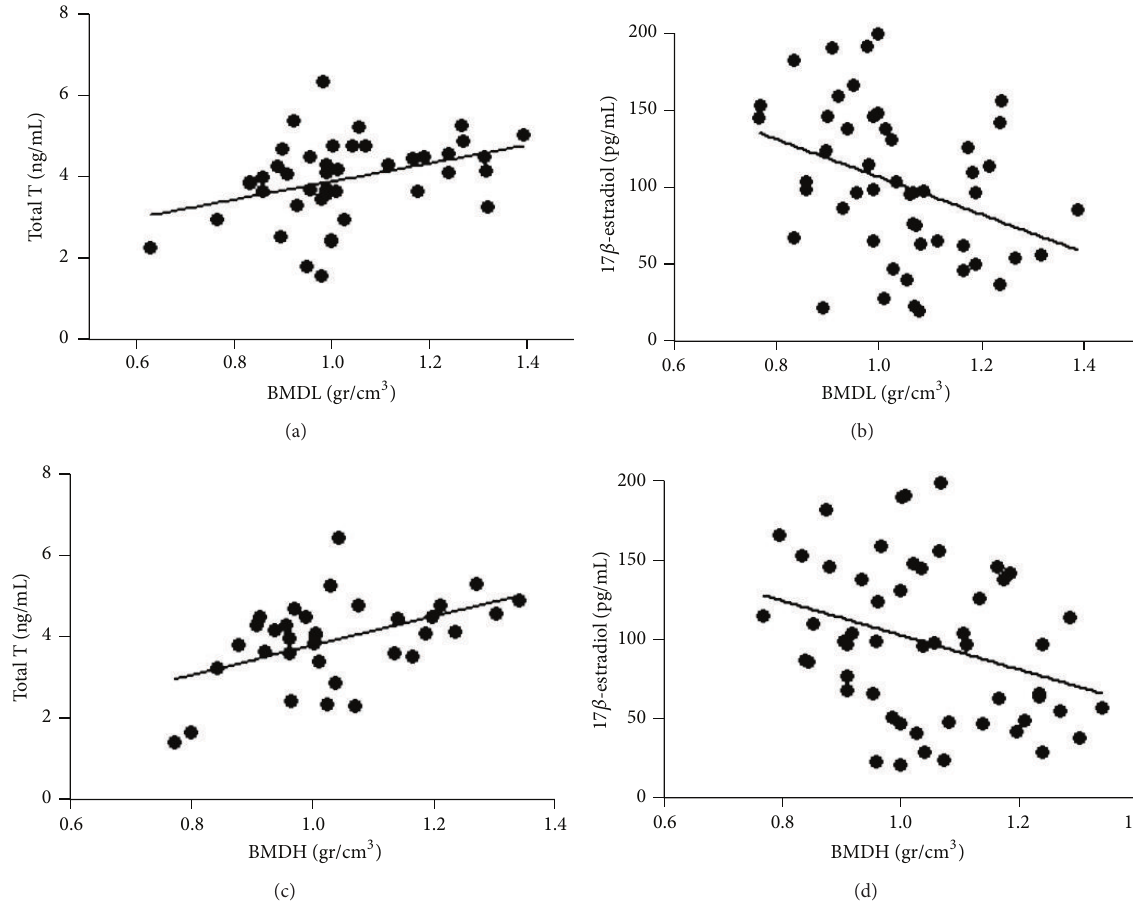
Figure 2: Correlation between (a) total testosterone (total T) and lumbar bone mineral density (BMDL) ( 𝑃 < 0.001 , 𝑟 2 = −0.20 ), (b) 17- 𝛽 -estradiol and BMDL ( 𝑃 < 0.001 , 𝑟 2 = −0.20 ), (c) total T and hip BMD (BMDH) ( 𝑃 < 0.001 , 𝑟 2 = −0.24 ), (d) 17 𝛽 -estradiol and BMDH ( 𝑃 < 0.001 , 𝑟 2 = −0.19